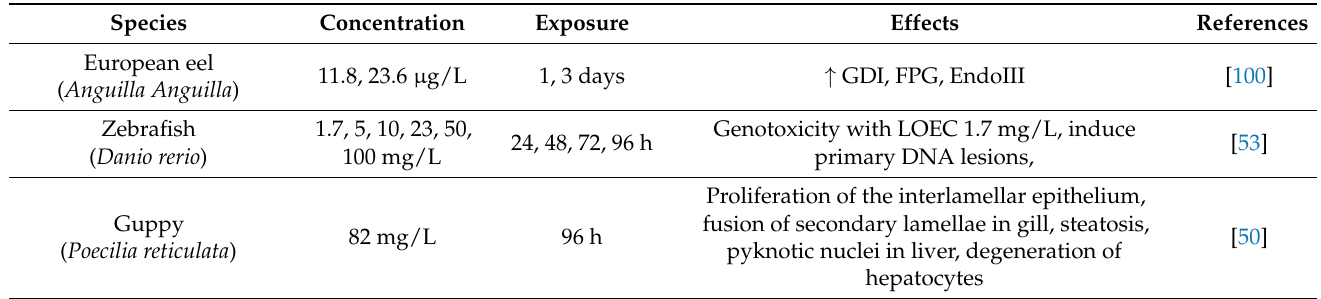
Table 7. Toxic effects of AMPA on aquatic